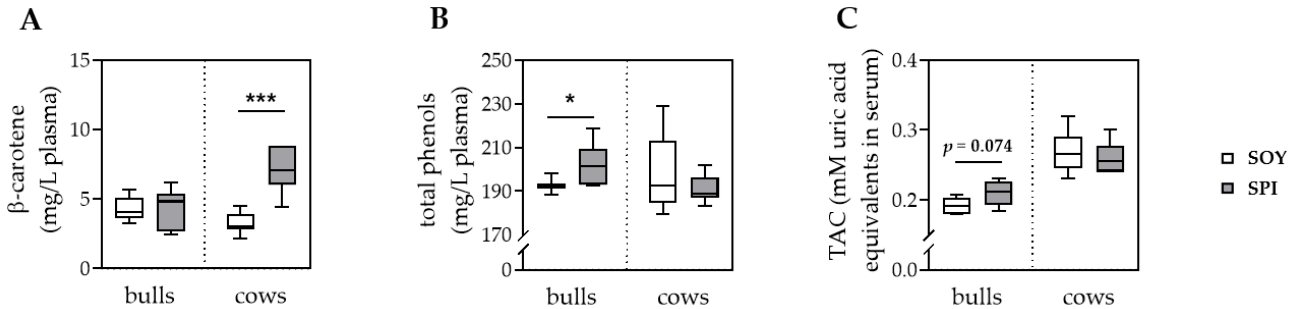
Figure 1. Antioxidants and antioxidant capacity in blood of fattening bulls and dairy cows fed with soybean meal (white boxes) or spirulina (gray boxes) as protein source. The concentrations of β -carotene ( A ) and total phenols ( B ) were analyzed in plasma, whereas the total antioxidant capacity (TAC, C ) was determined in serum. Results are presented in boxplots with Spear style whiskers (min to max). * p < 0.05; *** p < 0.001.